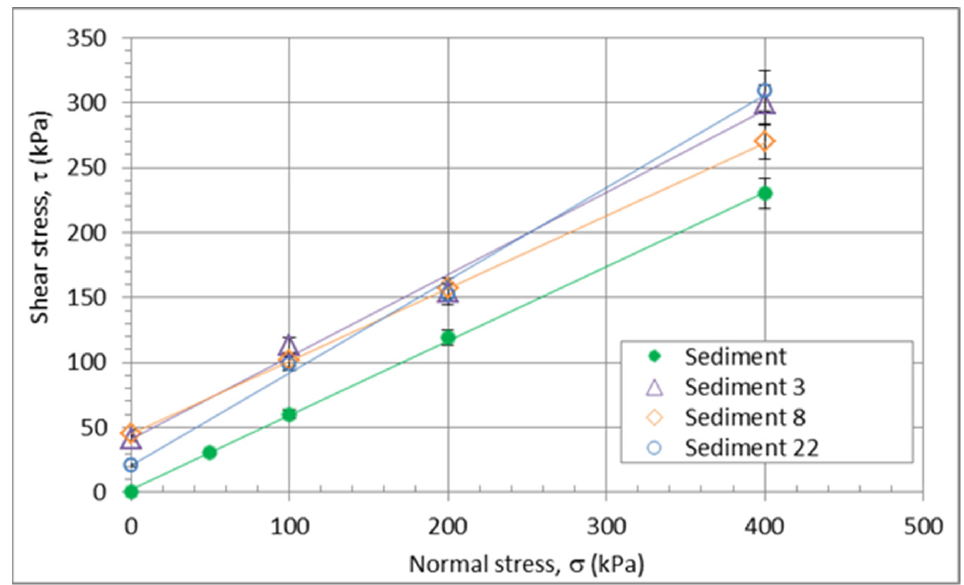
Figure 8. Unconfined compressive strength of the various mixtures; sediments only and sediments containing 3, 8, and 22% of lime additives (full markers representing the fully saturated samples, except the green one).